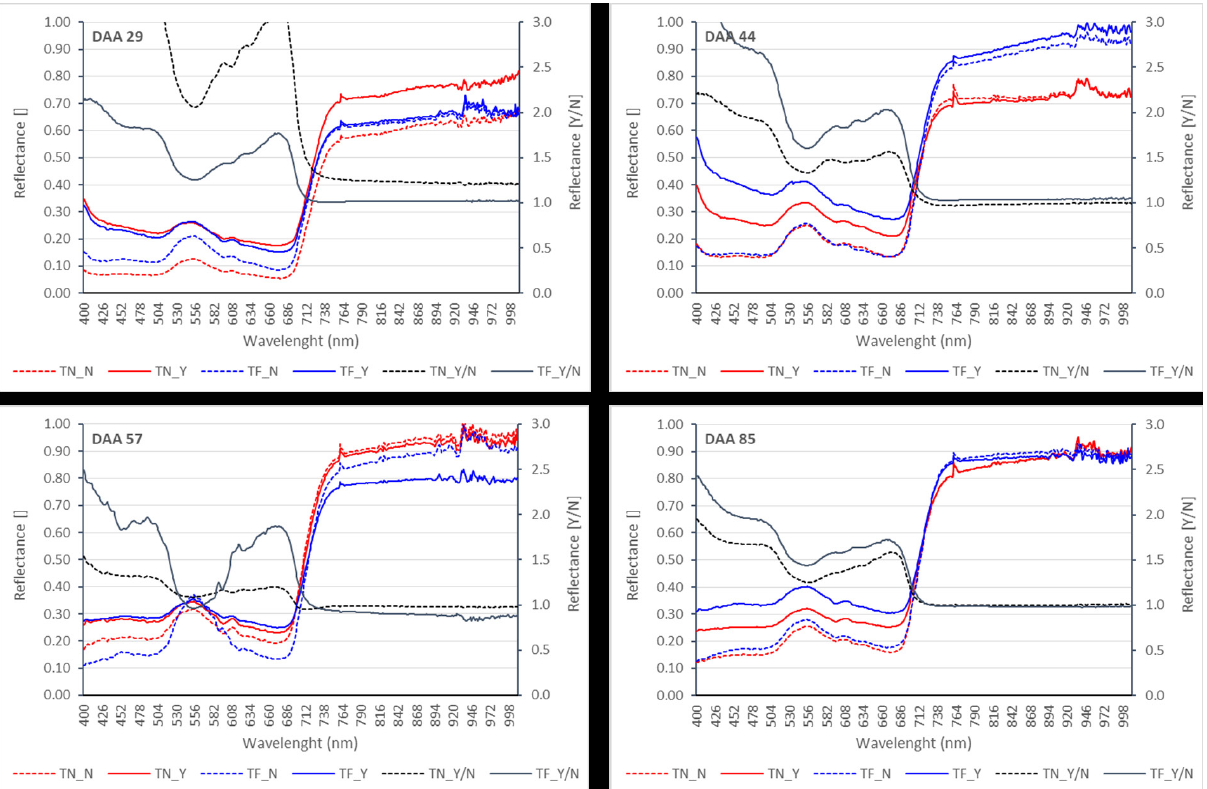
Figure 3: Average reflectance recorded in leaves of Touriga Nacional without kaolin (TN_N), Touriga Nacional with Kaolin (TN_Y), Touriga Franca without kaolin (TF_N), Touriga Franca with kaolin (TF_Y) during the four-measurements dates. The secondary Y axis represents the ratio of reflectance of leaves with kaolin per leaves without kaolin for TN (TN_Y/N) and TF